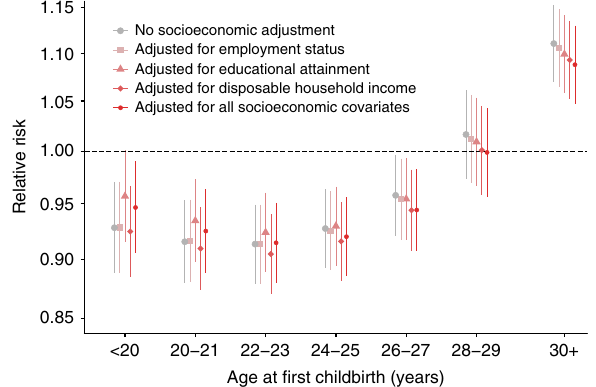
Fig. 1 Effect of different socioeconomic factors on long-term relative risk of breast cancer after fi rst childbirth in Denmark compared with nulliparous, by age at delivery. Error bars indicate 95% con fi dence